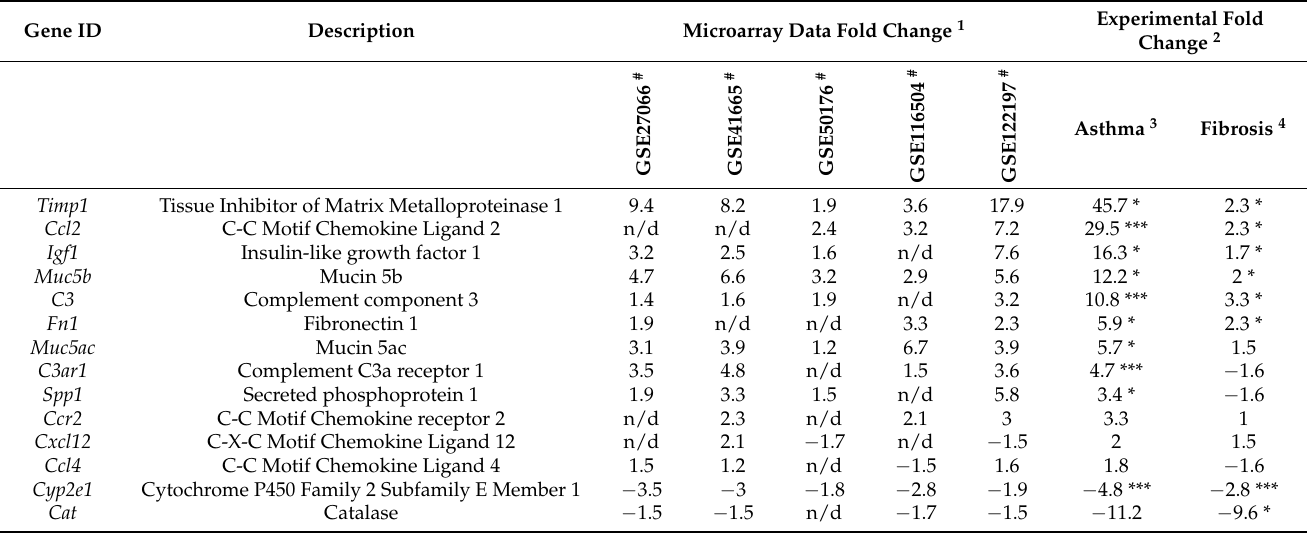
Table 1. The expression levels of genes identified as molecular markers of asthma and lung fibrosis by bioinformatics